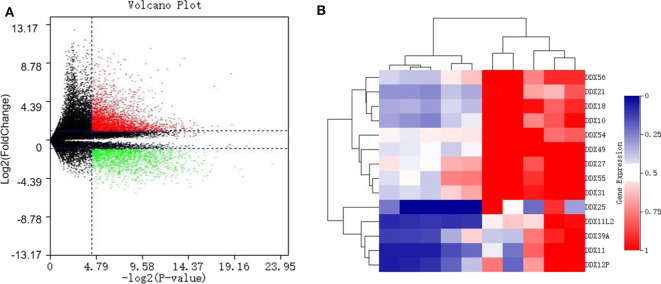
Identification of differentially expressed genes (DEGS) in the DEAD-box helicase (DDX) family between osteosarcoma tissue and adjacent normal tissue. (A) Volcano plot of all 60,492 expression genes included in the GSE126209 dataset. Red spots: up-regulated DEGs; green spots: down-regulated DEGs. (B) The heatmap with hierarchical clustering for differentially expressed genes in DDX family.